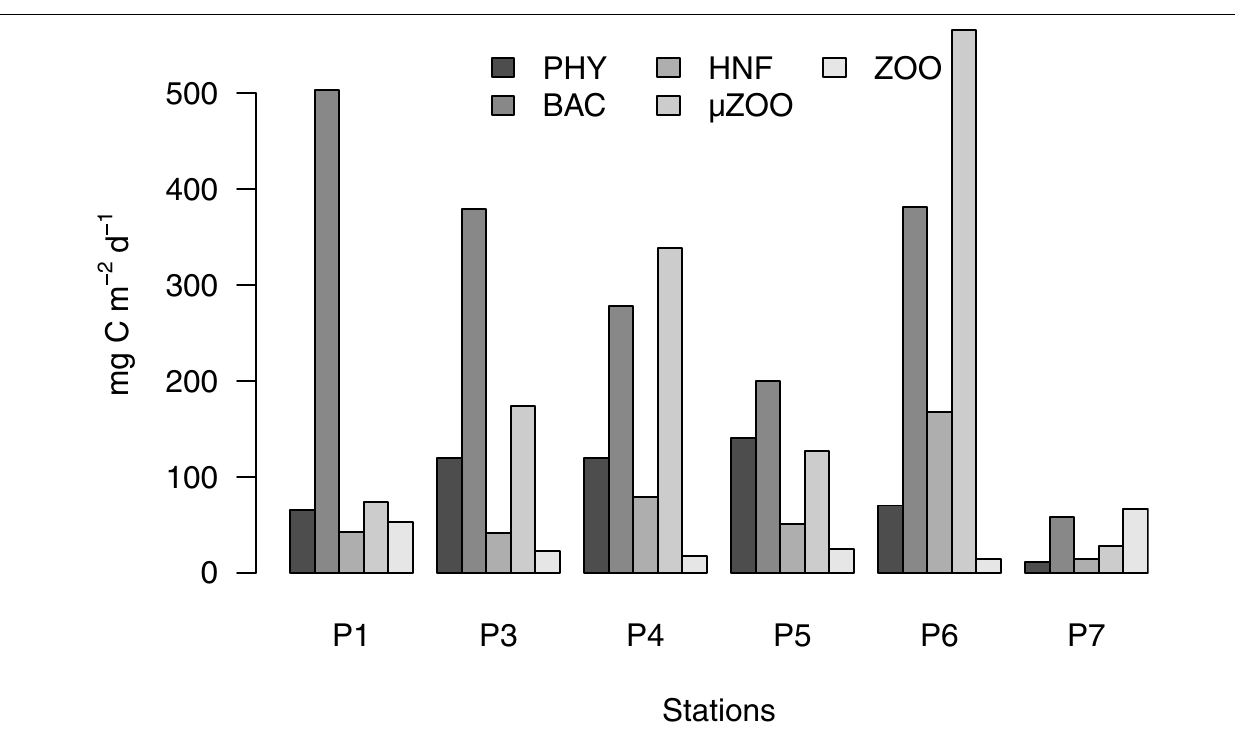
Frontiers in Marine Science |